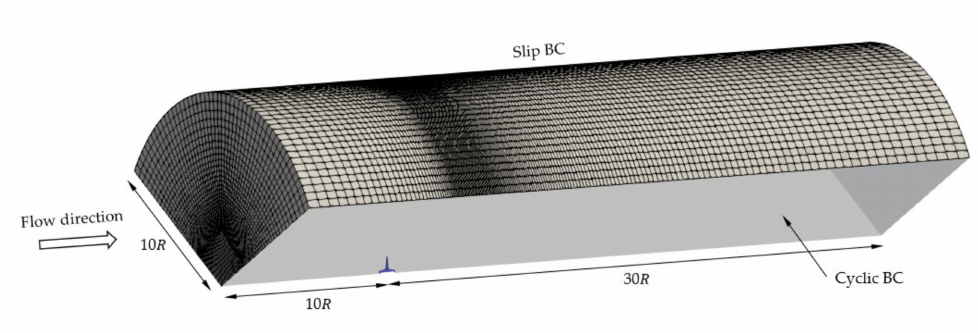
Figure 1. CFD model domain and boundary